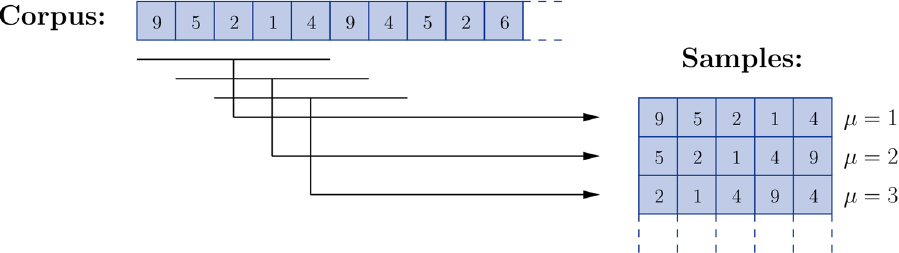
Figure 6. Training data. The corpus, a sequence of type indices, is segmented by overlapping substrings of size 2 K max + 1 (here K max = 2). These samples provide the information needed to train the basic module of our model, which describes the way a variable depends on its local context, i.e., on K max variables to its left and to its